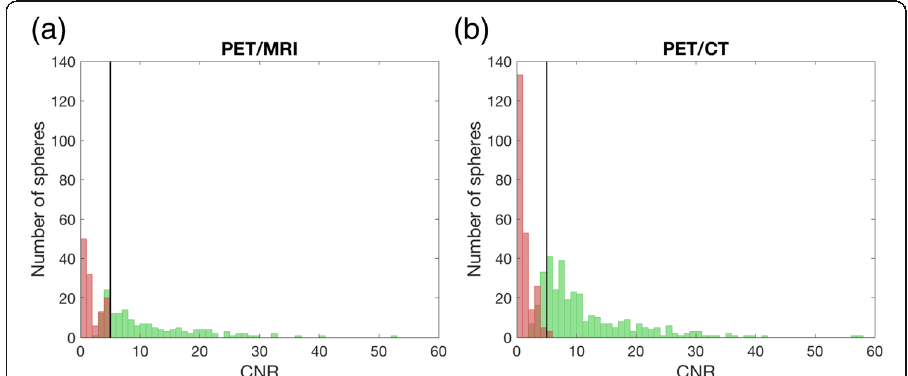
Fig. 7 Histograms of contrast-to-noise ratio (CNR) for detected (green) and non-detected (red) spheres for a PET/MRI and b PET/CT for all the reconstructions with similar number of true counts for the two systems. The black line represents CNR = 5 (Rose criterion). There are twice as many reconstructions for the PET/CT than for the PET/MRI due to the TOF